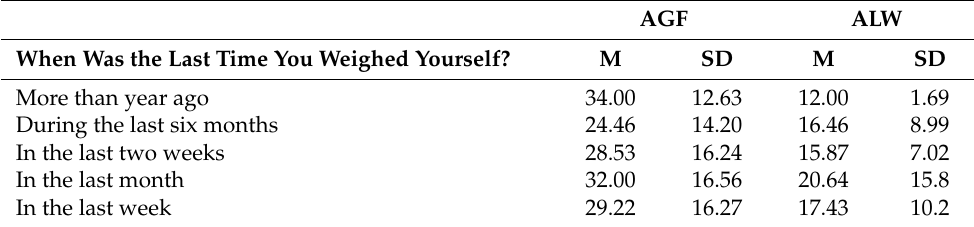
Table 3. Frequency of weighing and mean values of AGF and ALW.